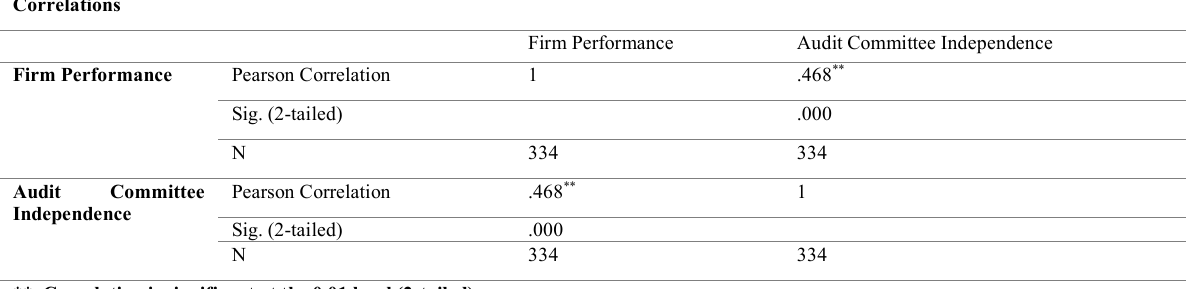
Table 9: Correlations between AUDIND and Firm Performance